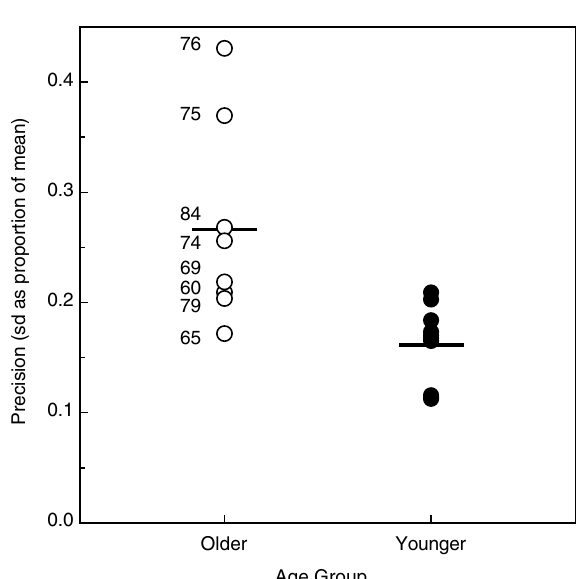
Figure 2. Estimates of precision (standard deviation of repeated judgments as a proportion of the mean) for each of the 18 individual younger and older participants. The individual older participants’ precision values are indicated by open circles, while those for the younger participants are indicated by filled circles. The horizontal lines indicate the mean for each age group. The individual (chronological) ages of the older adults are indicated beside their respective data